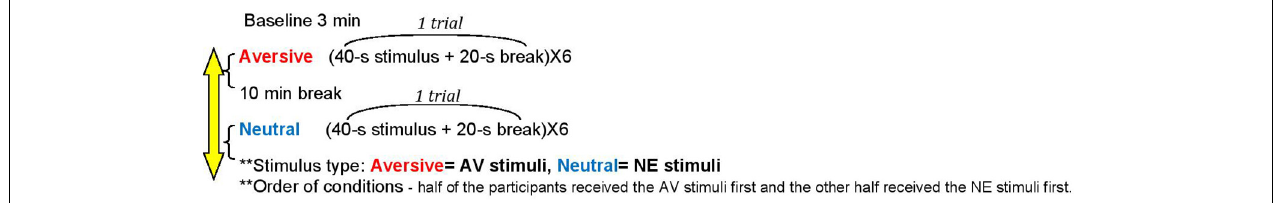
FIGURE 1 | The experimental design. Stimulus type: Aversive, AV stimuli; Neutral, NE stimuli. Order of conditions – half of the participants received the AV stimuli first and the other half received the NE stimuli first.